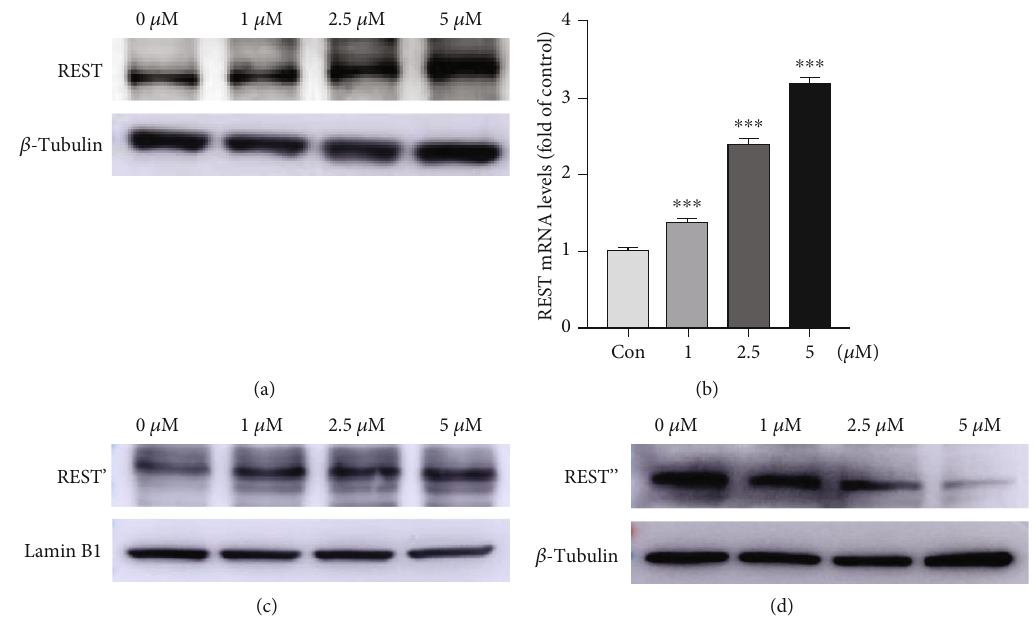
Figure 2: A β induced REST expression. (a, b) REST mRNA and protein expression was upregulated with the increase of concentration of 1-42 A β . (c) intranuclear REST was upregulated by treatment with A β 1-42 A β . ∗∗∗ p < 0 : 001 1-42